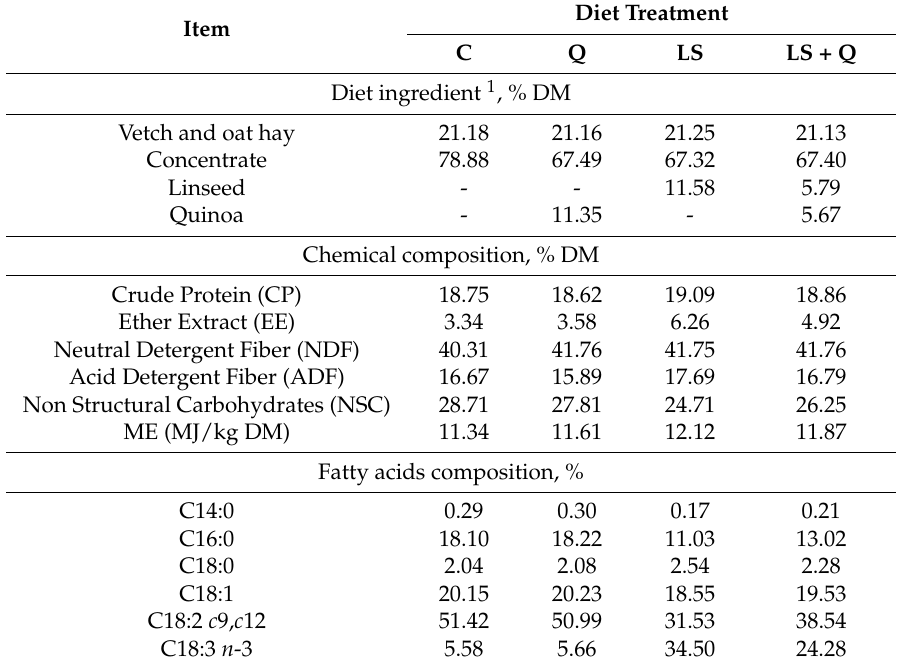
Table 1. Ingredients, chemical and fatty acid composition of experimental diets (C = control; LS = linseed; Q = quinoa seed; LS + Q = linseed +